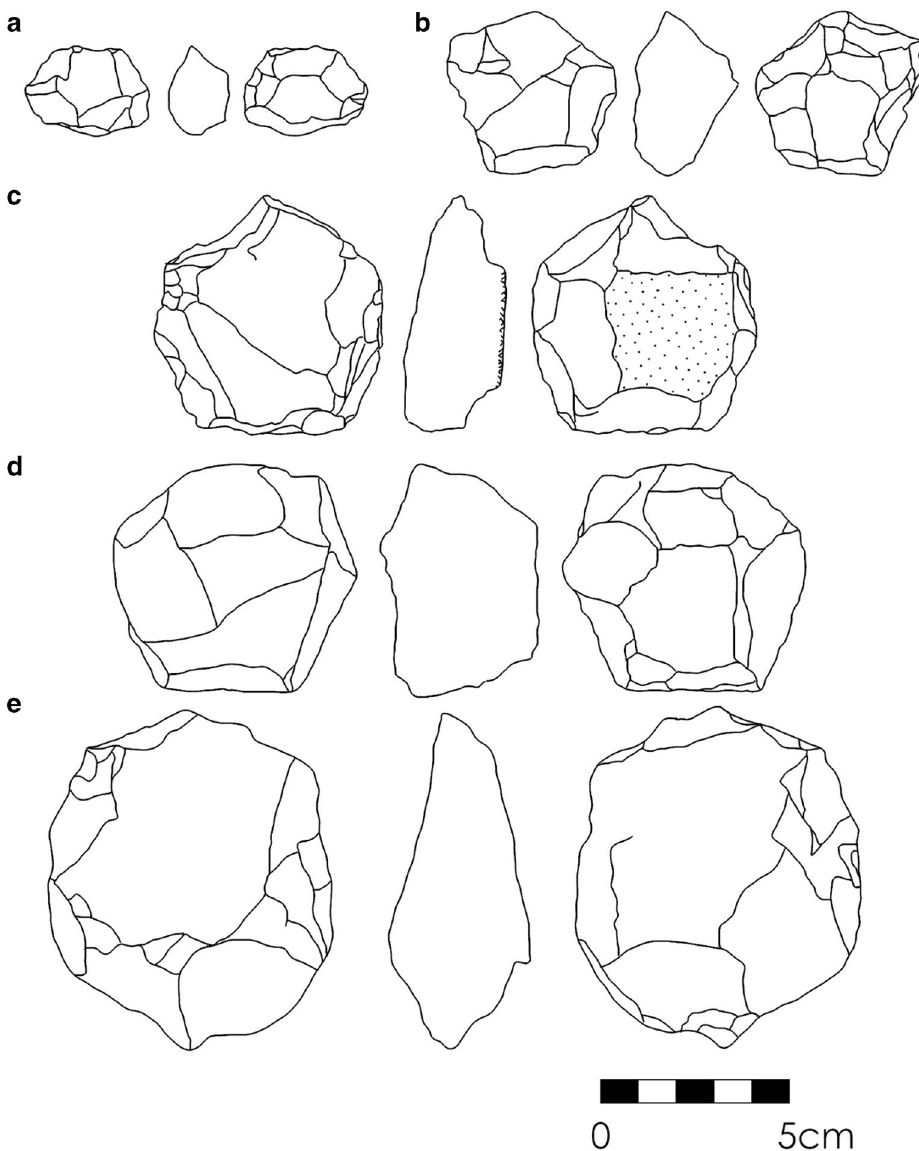
Figure 5. Hierarchical bifacial cores reported from Singi Talav assemblages Layer 3 ( a ) and Layer 4 ( b – e ) (redrawn from 49